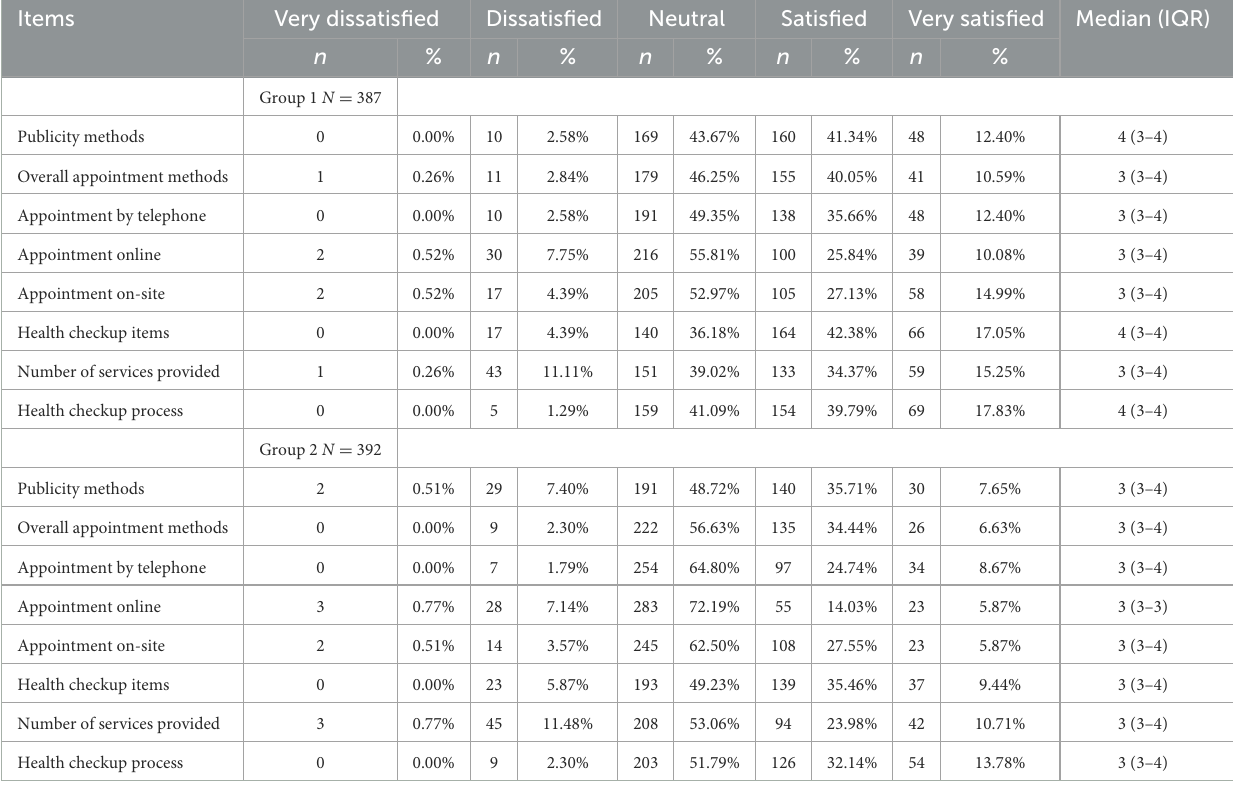
TABLE 2 Individuals’ satisfaction with the elderly health checkup program